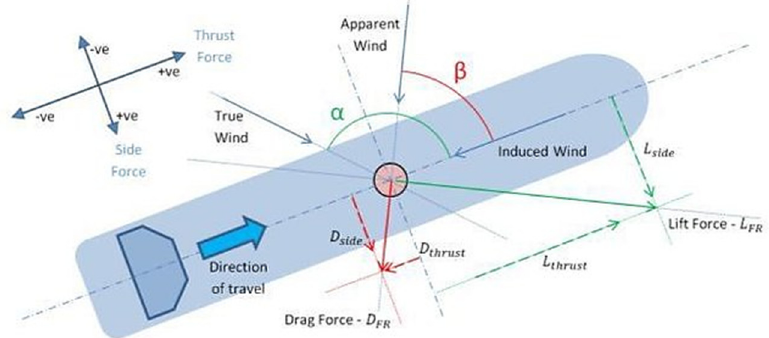
Figure 7. Representation of the forces acting on a rotor, reproduced from [22], with permission from David Pearson, 2022.